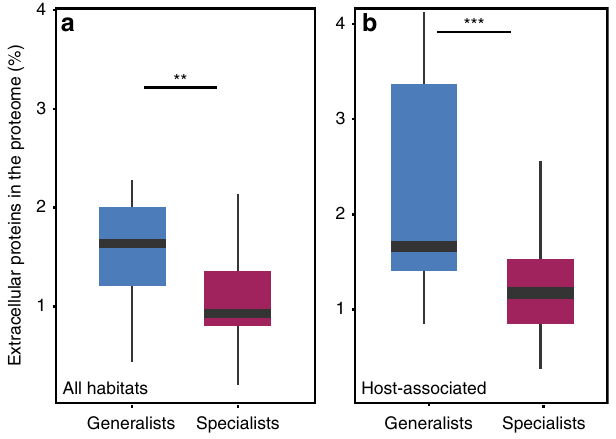
Fig. 6 Association between the frequency of genes encoding extracellular proteins and the classi fi cation of bacteria in terms of the range of habitats where they could be identi fi ed. The left panel indicates the results for all environments (sets a and c , described in Supplementary Information), and the right panel for host-associated habitats (sets b and d ). Wilcoxon-Rank test. ** P < 0.01; *** P < 0.001. Source data are provided as a Source Data fi